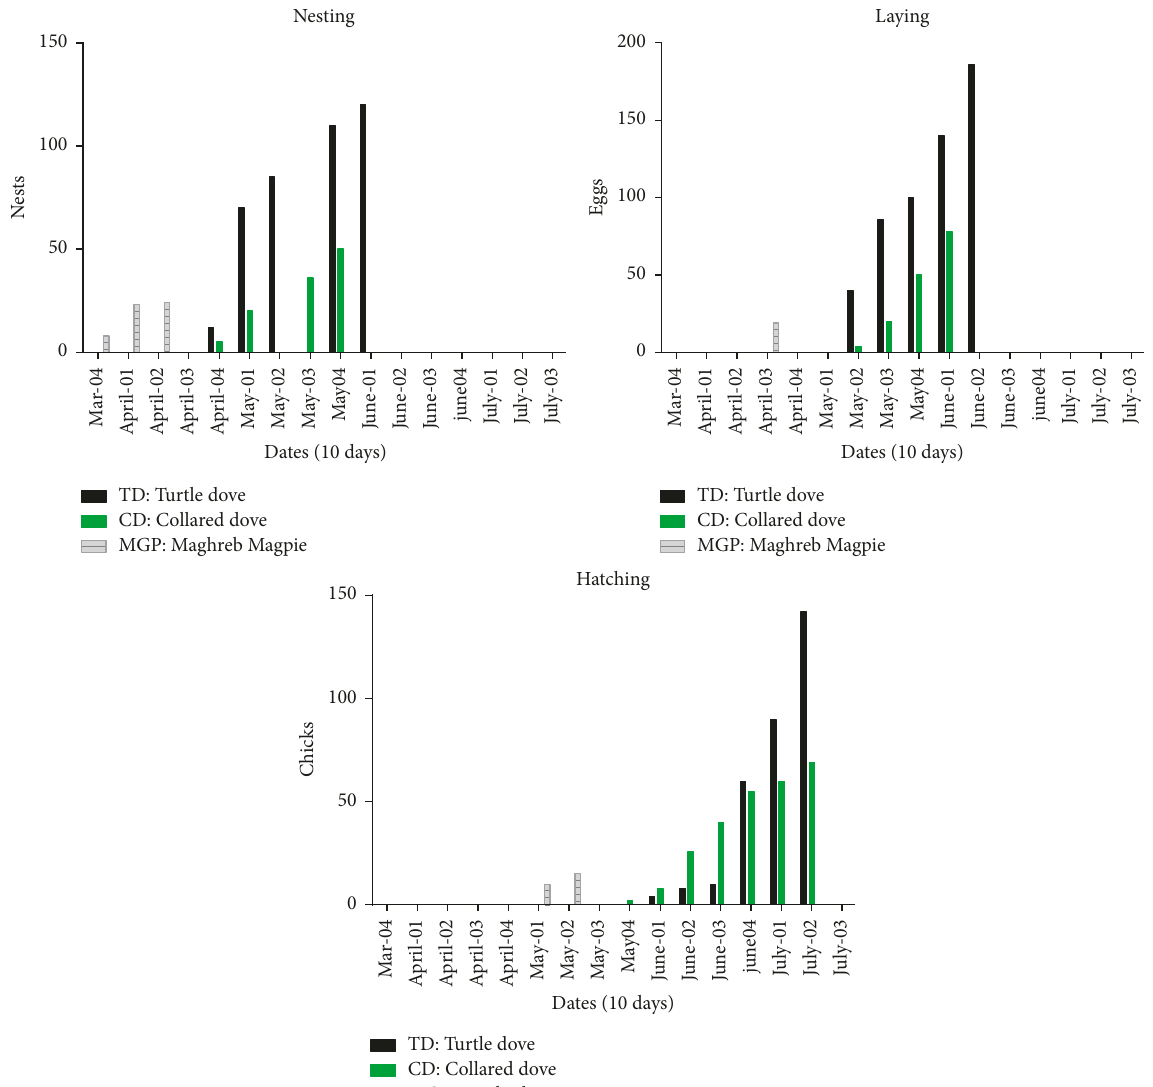
Figure 6: Breeding chronology (nest construction, laying, and breeding dates) of turtle dove, collared dove, and Maghreb magpie at Fez between 2017 and